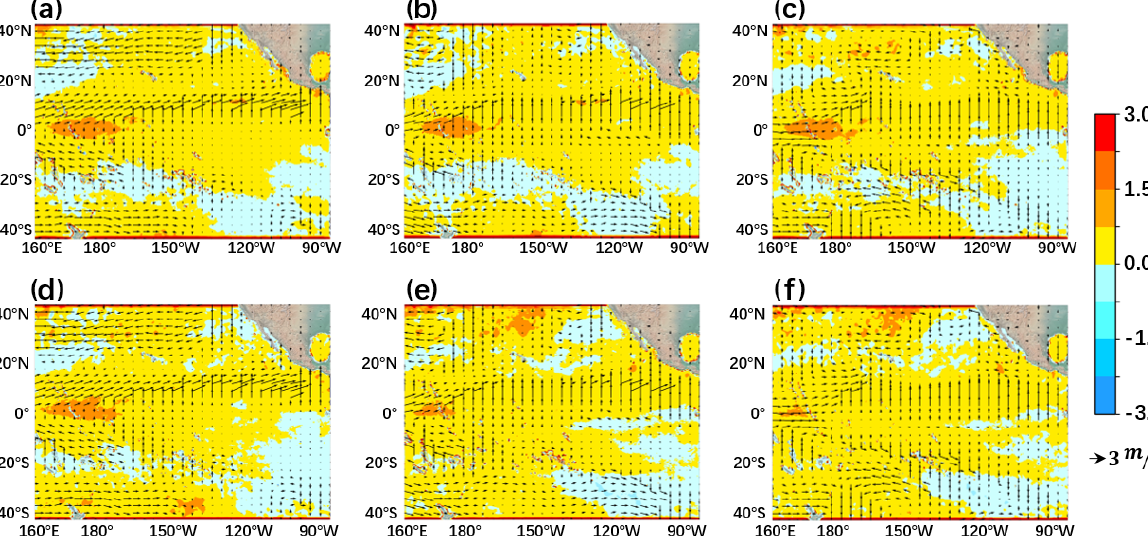
Figure 20. The same with Fig. 17 but for the neural SST and wind anomalies evolutions in January to March